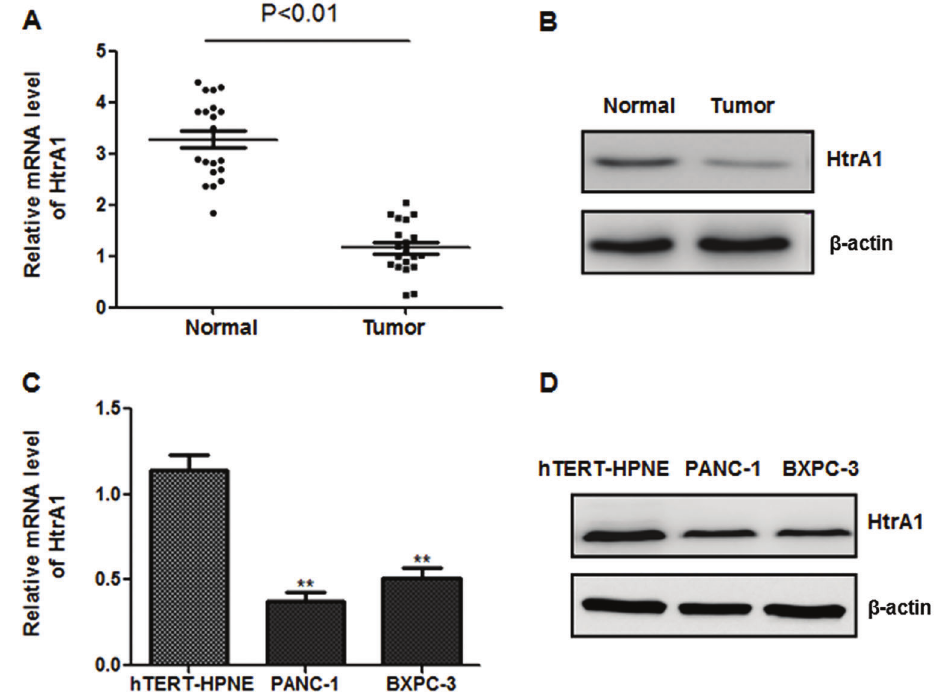
Figure 1. High temperature requirement factor A1 (HtrA1) expression was detected by real-time PCR and western blot in human pancreatic cancer tissue and adjacent normal tissue ( A and B ). Human pancreatic cancer cell lines including PANC-1 and BXPC-3 and a human pancreatic duct epithelial-like cell line hTERT-HPNE were subject to real-time PCR ( C ) and western blot ( D ) for detection of HtrA1 expression. Data are reported as means ± SD. **P o 0.01